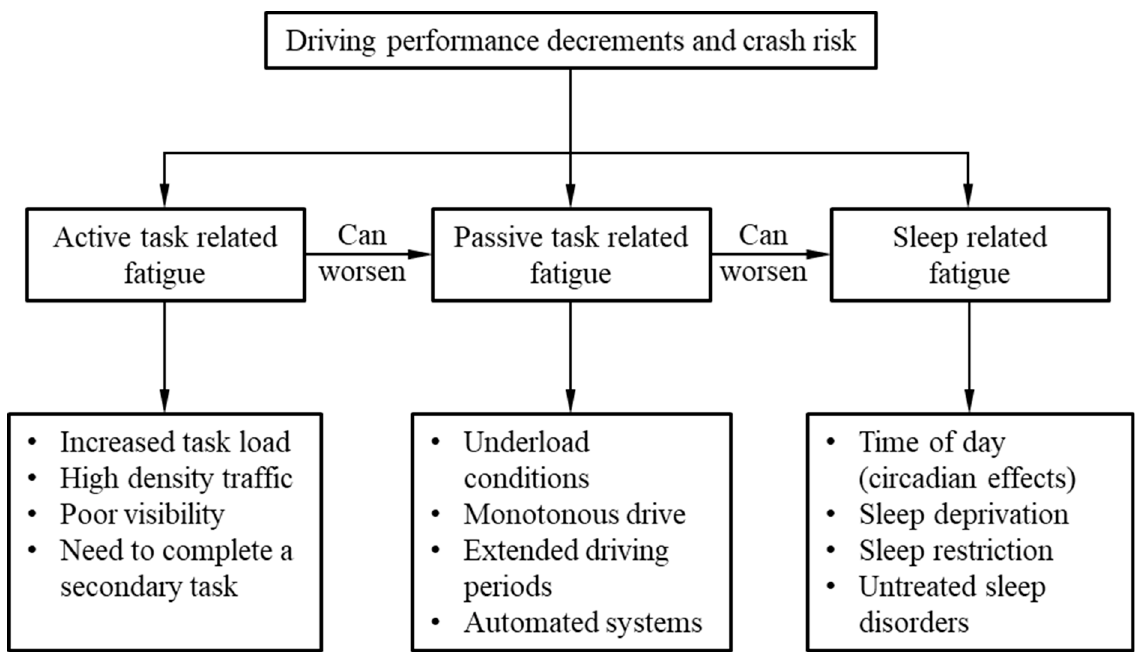
Figure 3. Model for the fatigue